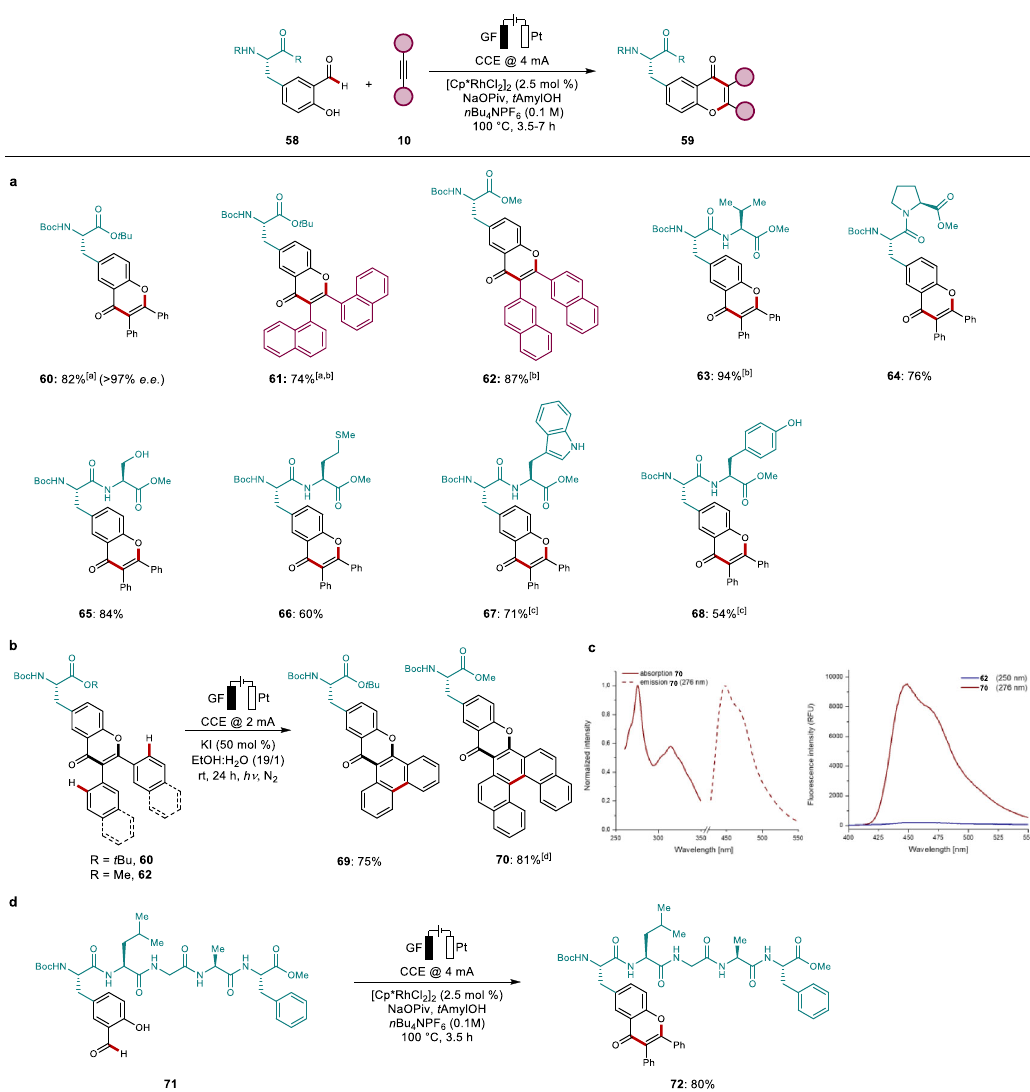
Fig. 5 Development of amino acid and peptide labels. a Scope of rhodaelectro-catalyzed peptide labeling. b Photoelectrochemical annulation towards π -extended peptide labels. c Absorption and emission properties of 62 (10 mg/L) and 70 (0.5 mg/L) in CHCl pentapeptide 71 . a With t AmylOH/H 2 O (3:1). b 7 h. c With 5.0 mol % of [Cp*RhCl 2 ] 2 . d With MeOH instead of